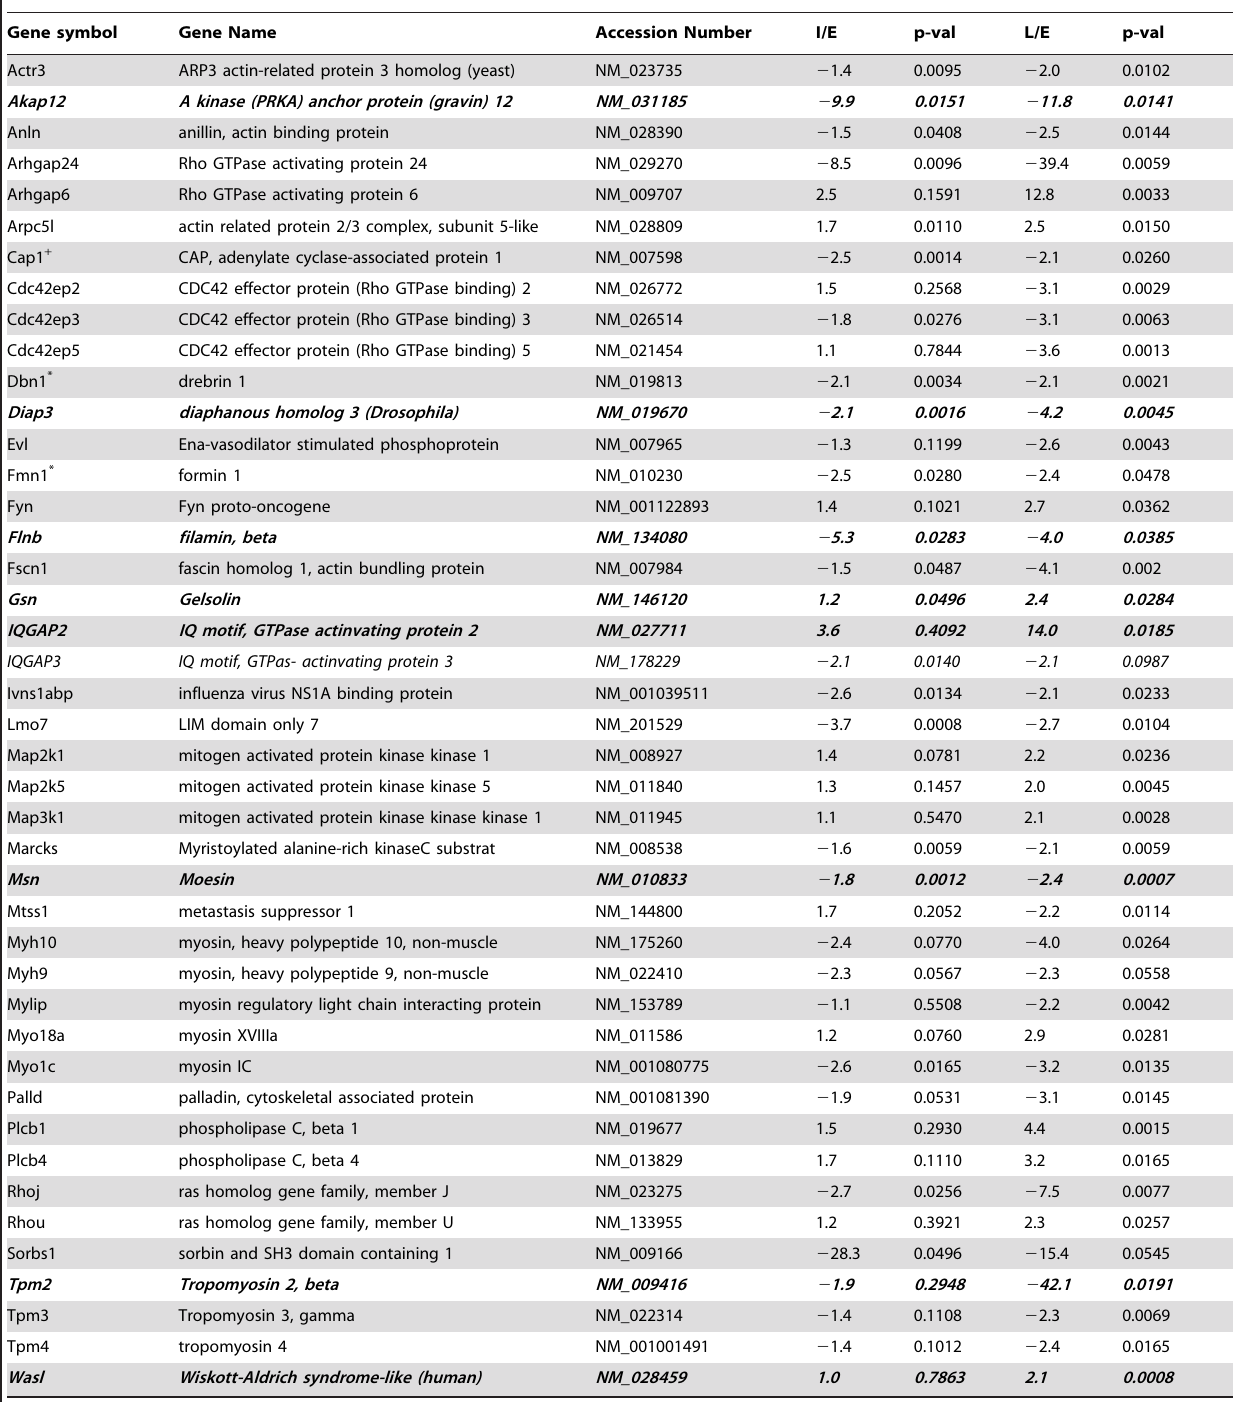
Table 3. Differentially expressed actin binding regulating genes in MOSE cell